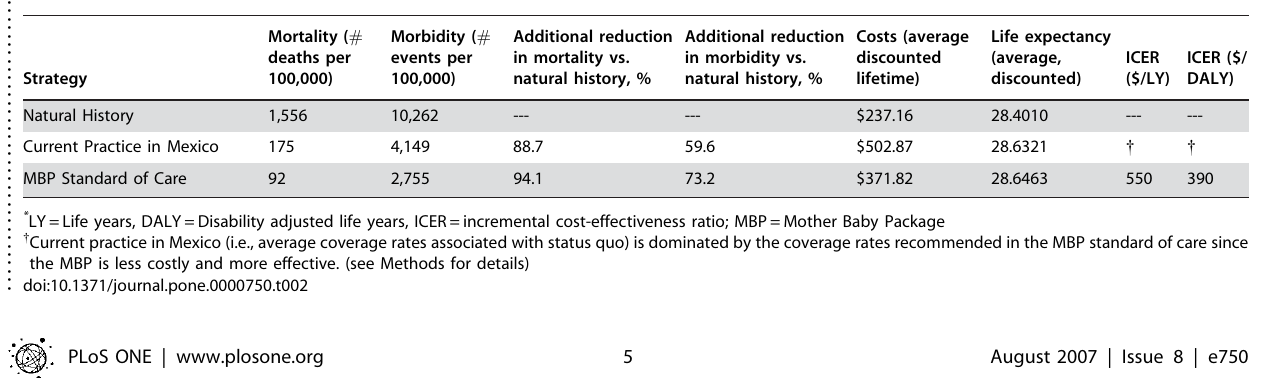
Table 2. Benefits, costs, and cost-effectiveness of current practice in Mexico (compared with no maternal care), and upgrading to the coverage rates in the WHO Mother Baby Package (MBP) standard of care.* .. ... .... ... ... .... ... ... .... ... ... .... ... ... .... ... ... .... ... ... .... ... ... .... ... ... .... ... ... .... ... ... .... ... ... .... ... ... .... ... ... .... ... ...